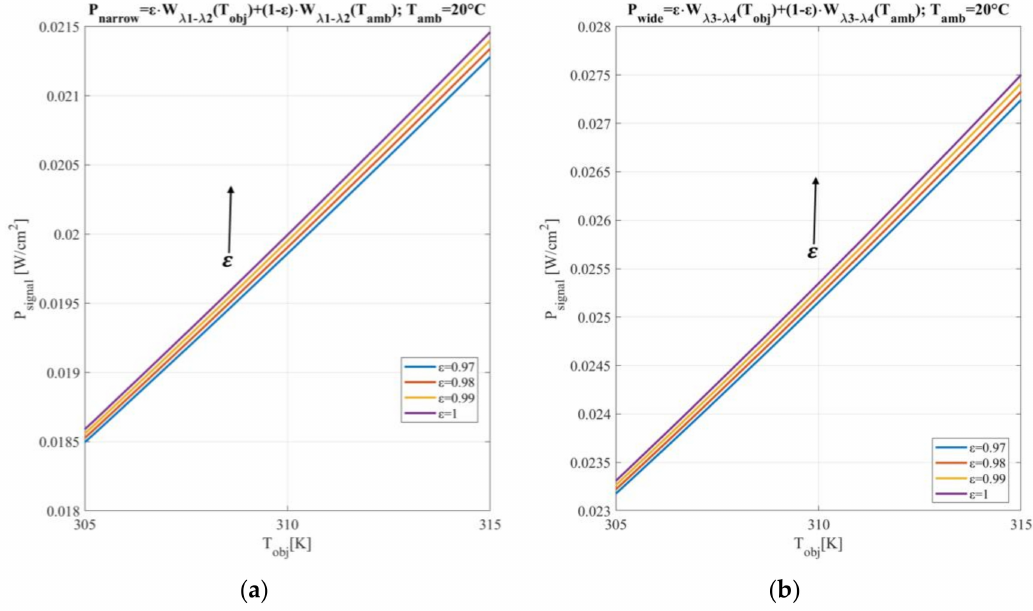
Figure A1. Calculated incident power, emitted and reflected from the object at ambient tem- perature of 20 ◦ C, for two different bandpass filters; ( a ) narrow bandpass 8–14 µ m; ( b ) wide bandpass 5.5–13.5 µ